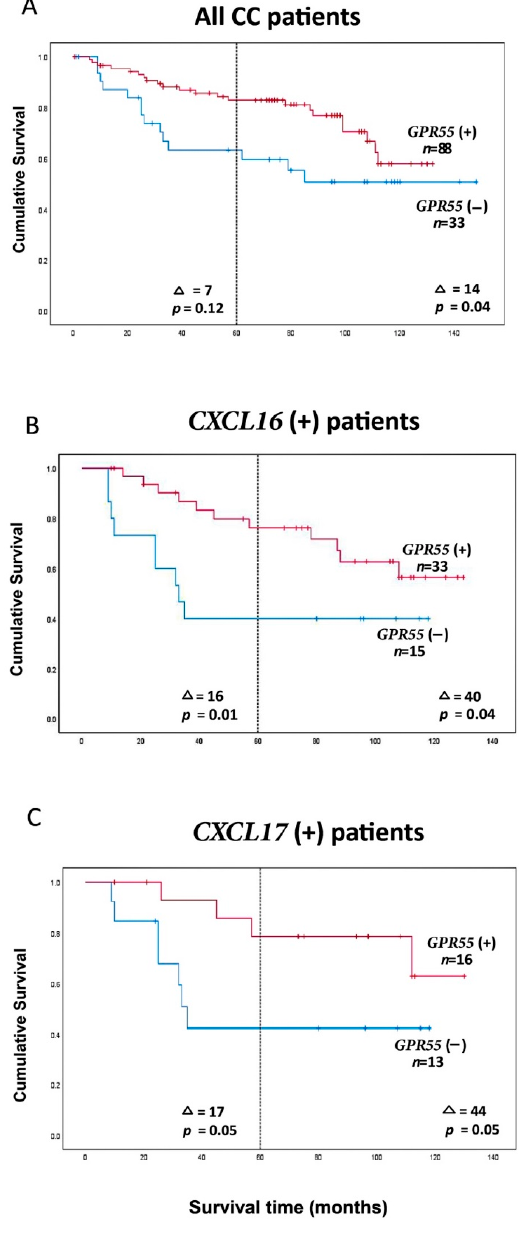
Figure 3. ( A ) Kaplan–Meier cumulative survival curves for all 121 CC patients. Each patient is represented by the lymph node with the lowest GPR55 mRNA value. The cutoff level between the two groups was 0.1365 GPR55 mRNA copies/18S rRNA unit. ( B ) Kaplan–Meier cumulative survival curves for GPR55( − ) and GPR55(+) patients. Analysis is restricted to patients with CXCL16 mRNA levels in their highest lymph node > 7.2 mRNA copies/18S rRNA unit. The cutoff level between the two groups was 0.1365 GPR55 mRNA copies/18S rRNA unit. The number of patients was 48. ( C ) Kaplan–Meier cumulative survival curves for GPR55( − ) and GPR55(+) patients. Analysis is restricted to patients with CXCL17 mRNA levels in their highest lymph node > 0.0014 mRNA copies/18S rRNA unit. The cutoff level between the two groups was 0.1365 GPR55 mRNA copies/18S rRNA unit. The number of patients was 29. Patients were followed for 12 years. Differences in disease-free survival time after surgery between the two groups are given as a ∆ -value in months and statistical significance as p -values; n = number of patients in the respective group.